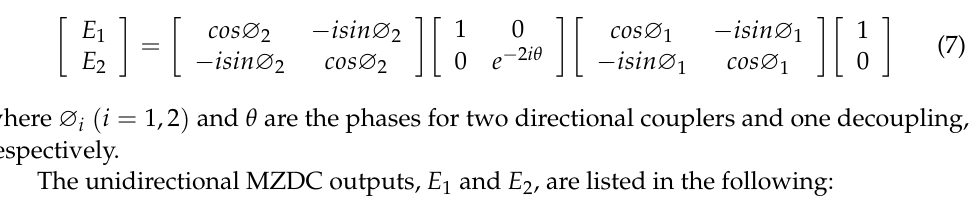
Figure 3. The mode profiles for the ( a ) n s and ( b ) n a , under 380 nm width and 220 nm height. The delay length in the MZDC decoupled arms is optimized to obtain the flat wave- length response while maintaining the dedicated splitting ratio. For the MZDC